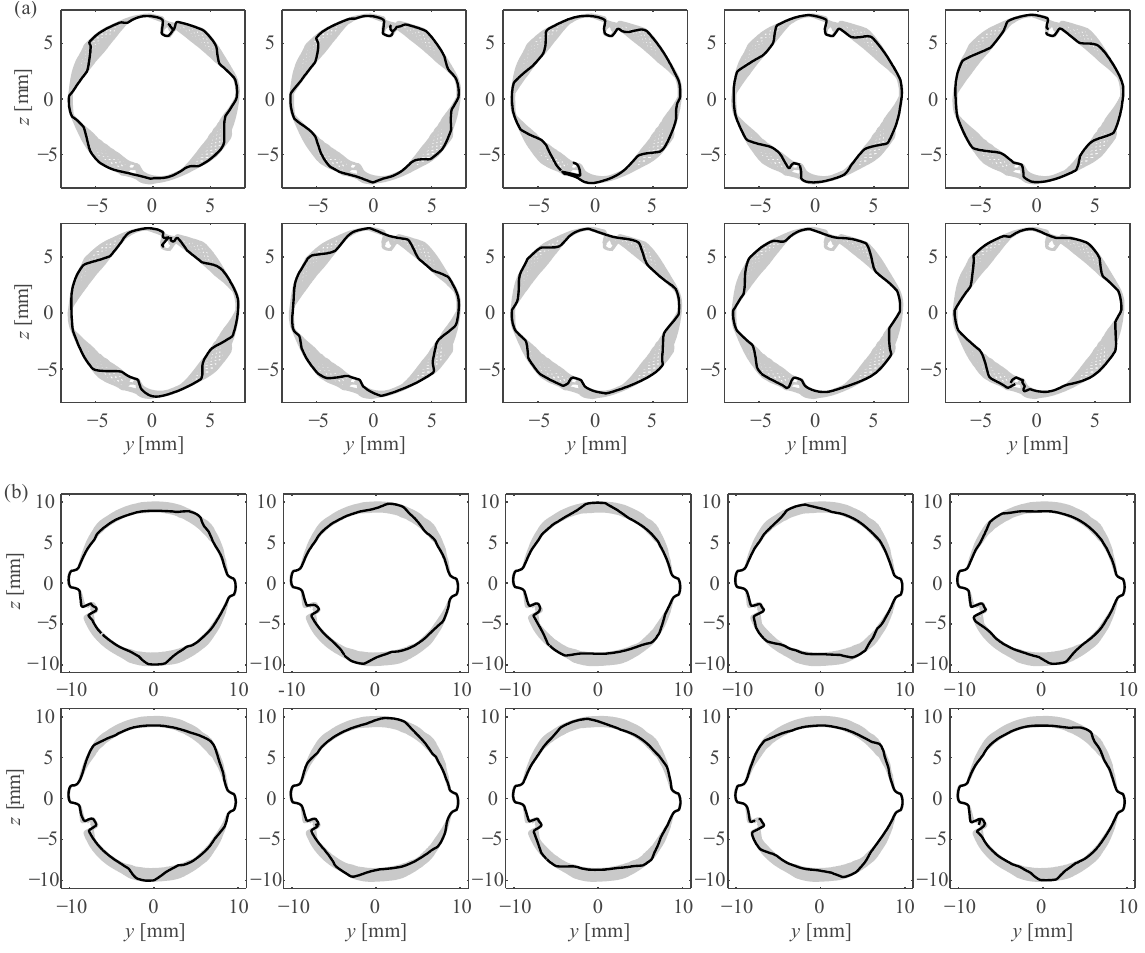
Figure A1. Variation of cross-sectional geometry showed on ten equally spaced cross-sections within a repeating rib pattern: ( a ) specimen cw01 ∅ 14 and ( b ) specimen cw03 ∅ 18 mm.